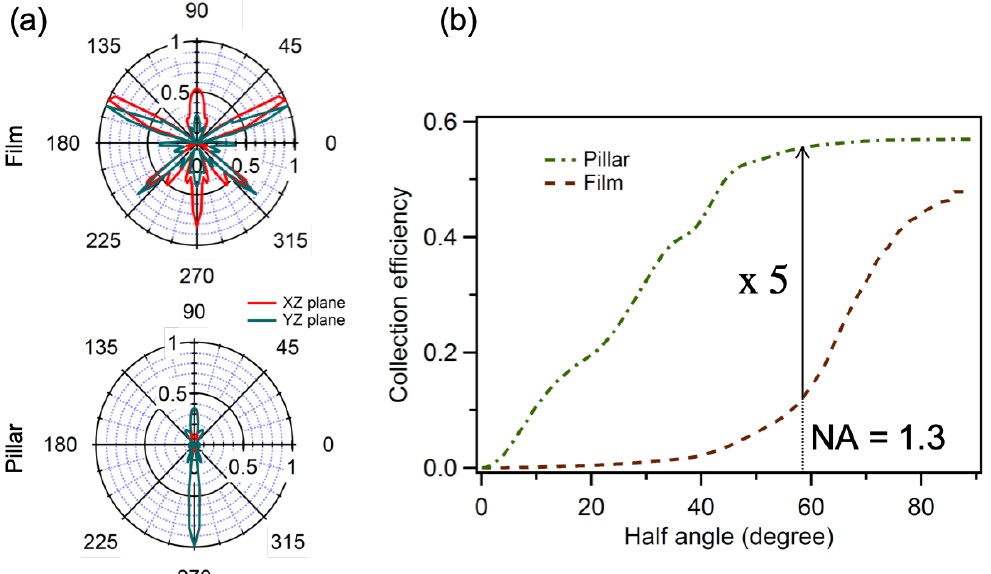
Figure 9. ( a ) Simulation of radiation patterns, in ( xz ) and ( yz )–plane, of a single dipole embedded in different configurations. Top: emission diagram of a single dipole embedded in a thin film. Bottom: emission diagram of a single dipole embedded in a polymeric pillar. For both cases, the dipole was assumed to be in x -axis. ( b ) Calculation of the collection efficiency of the SHG signal as a function of the half angle of the objective lens for two cases. An enhancement factor of 5 is